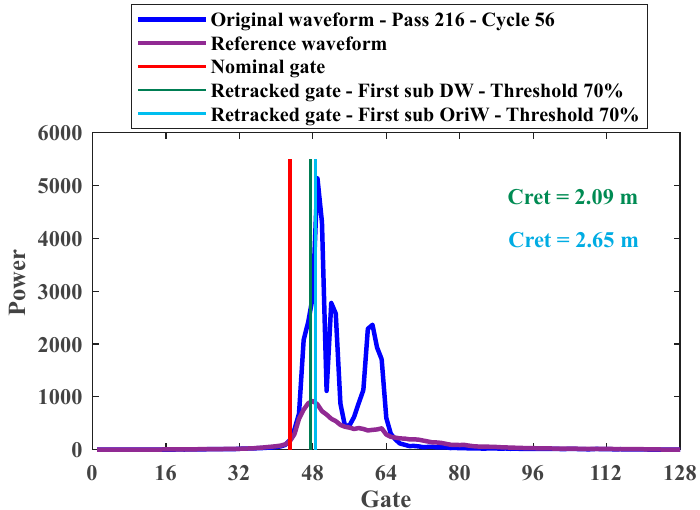
Figure 11. Retracking of the first sub-waveform of the original and decontaminated waveform of pass 216 from cycle 56 over the Bay of Biscay.